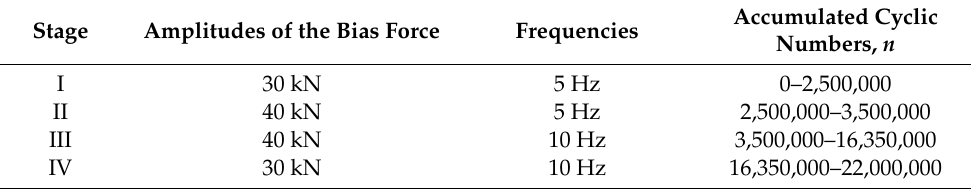
Table 3. Cyclic loading test scheme of structural expanded polystyrene concrete (EPS) concretes.